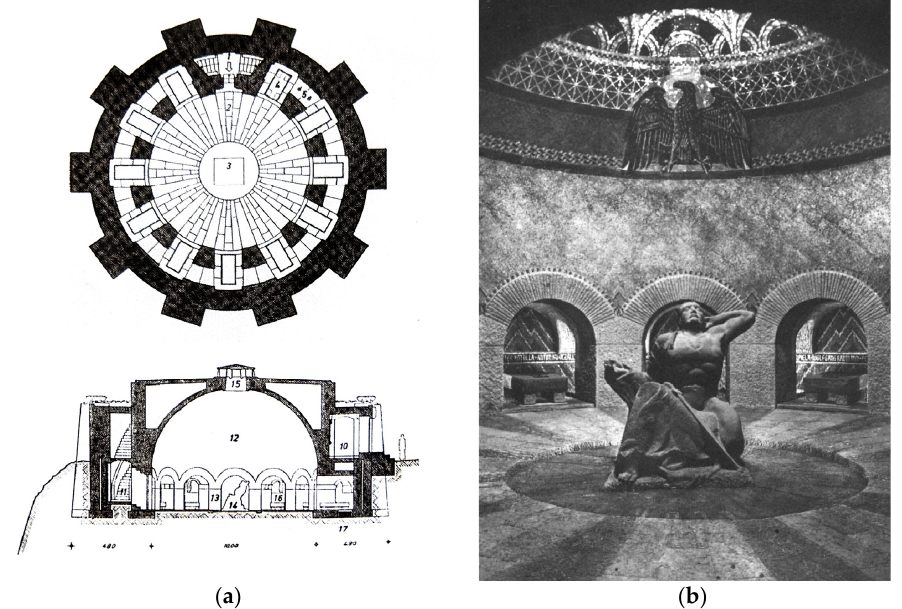
Figure 2. Saint Anne Mountain, monument mausoleum of the fallen German soldiers from the Volunteers Corps (Freikorps), ( a ) Plan and section, design by Robert Tichler (Das Freikorps-Ehrenmal auf dem Annaberg 1939, p. 102), ( b ) Interior of the Hall of the Dead, 1939 (Opole Digital Library).